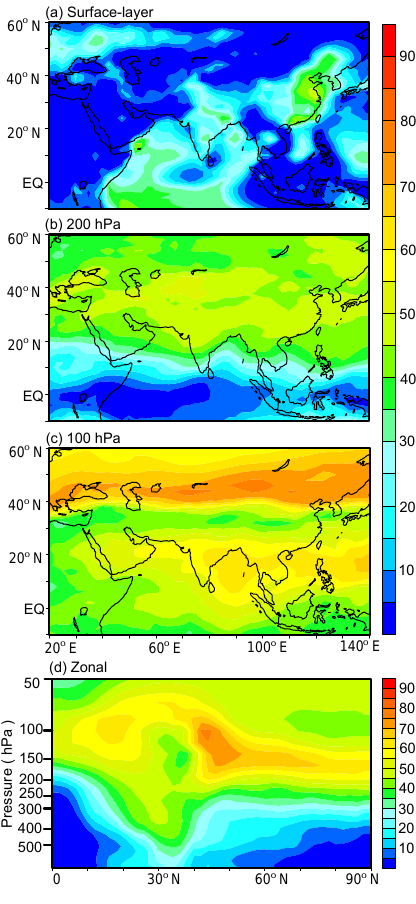
Figure 10. Simulated contributions of nitrate to PM 2 . 5 ( C NIT = [NIT]/[PM 2 . 5 ] × 100%) averaged over summer (June– August) of year 2005 at (a) the surface layer, (b) 200hPa, and (c) 100hPa. (d) The latitude–altitude cross section of simulated C NIT (%) averaged over 70–105 ◦ E.